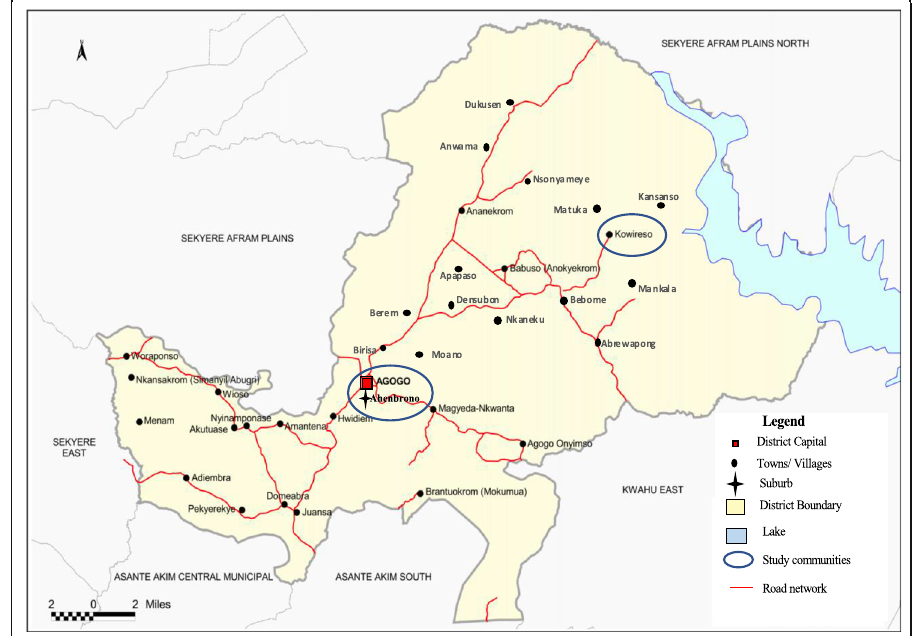
Fig. 3 Map of Asante Akim North District showing case study communities.Source: Adapted based on Ghana Statistical Service